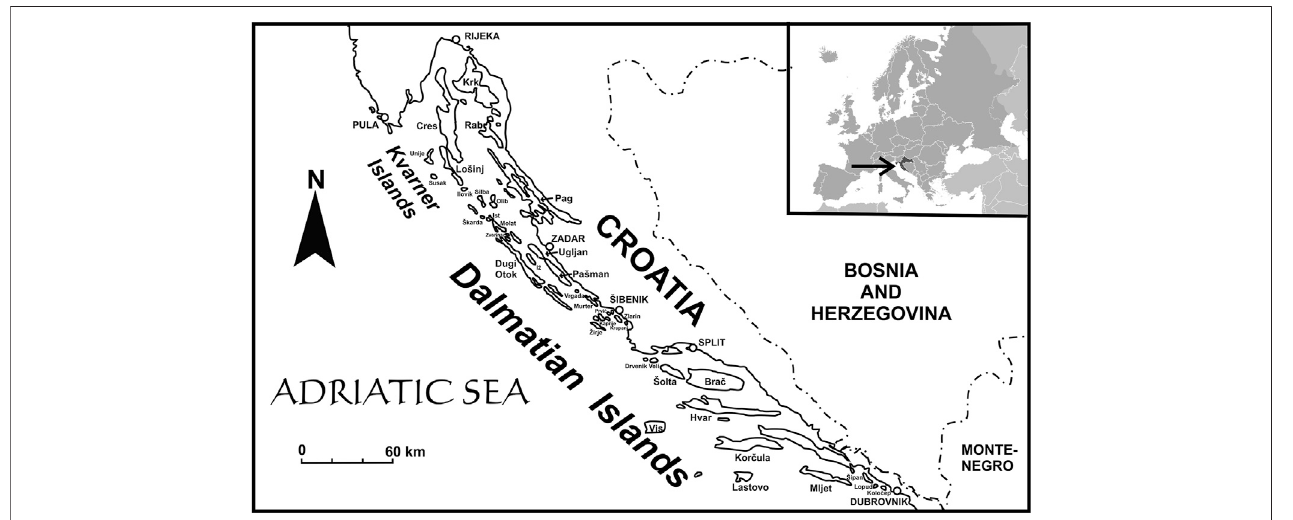
FIGURE 1 | The studied islands. All the named islands are those where interviews were carried out.